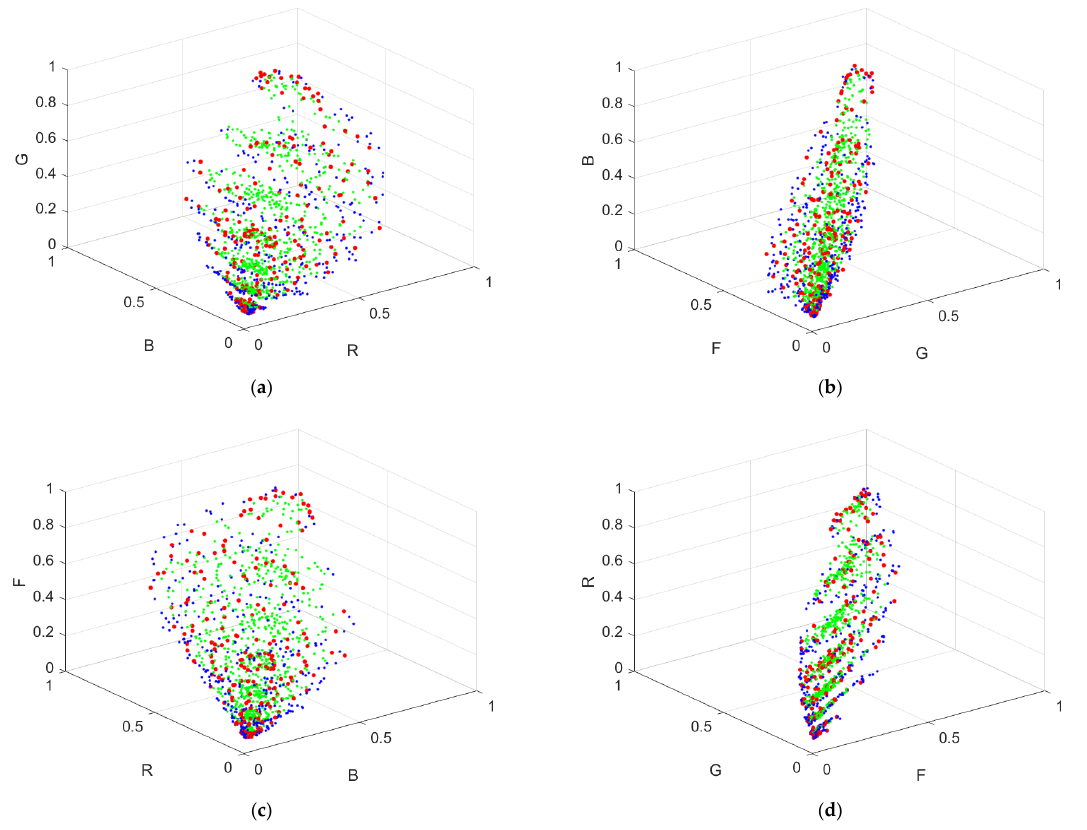
Figure 5. Color points of light reflected from the Munsell color chips in the ( a ) RGB, ( b ) GBF, ( c ) BFR and ( d ) FRG signal spaces, using the RGBF camera. The 202 reference samples are shown as red dots. The 726 inside samples and 340 outside samples are shown as green and blue dots, respec- tively.